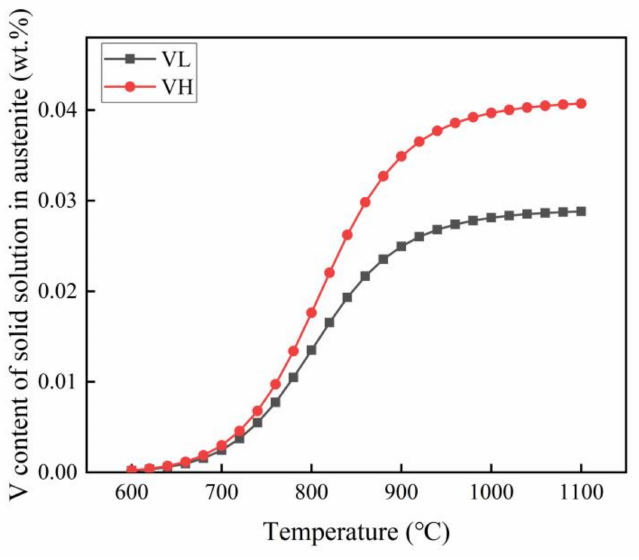
Figure 14. Relationship between temperature and V content of solid solution in austenite of VL and VH